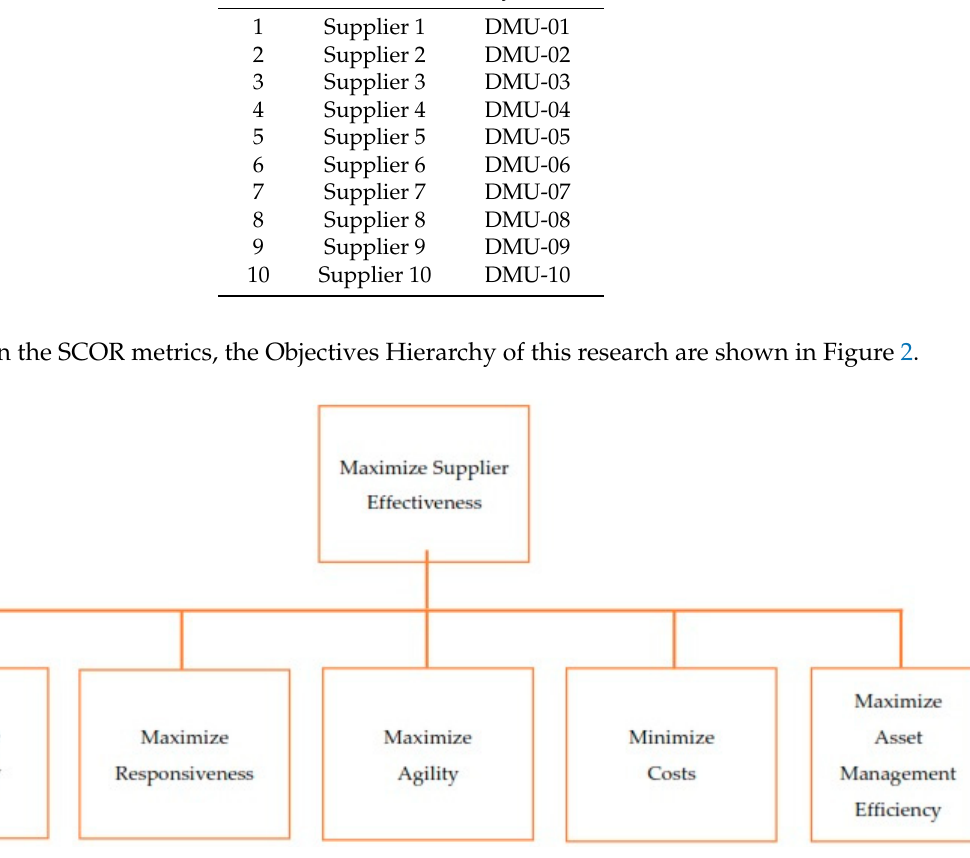
Figure 2. The Objectives Hierarchy based on SCOR metrics.